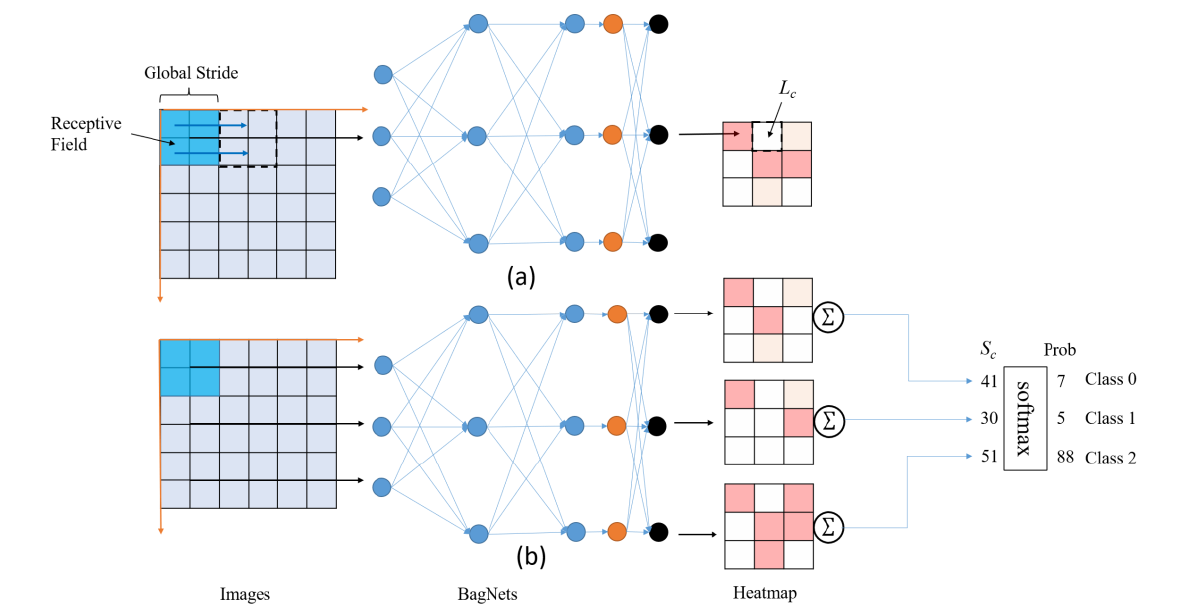
Figure 1. The basic principle of DNN-based BagNets (the image size is 6 × 6 pixels and the model has a receptive field of 2 × 2 pixels and a global stride of 2, The blue, orange and black dots represent the convolution layer, the global average pooling layer and the full connection layer respectively. The white, pink, and orange squares show different intensities of activation, increasing in order). ( a ) BagNets extract class activations (logits) on each patch. ( b ) Evaluating all patches yields one heatmap per class.